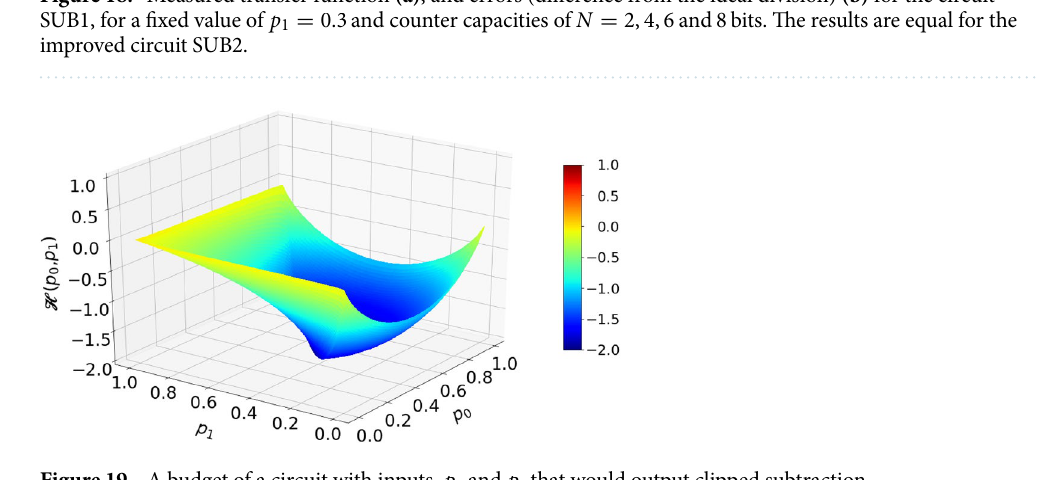
Figure 19. A budget of a circuit with inputs p 0 and p 1 that would output clipped subtraction